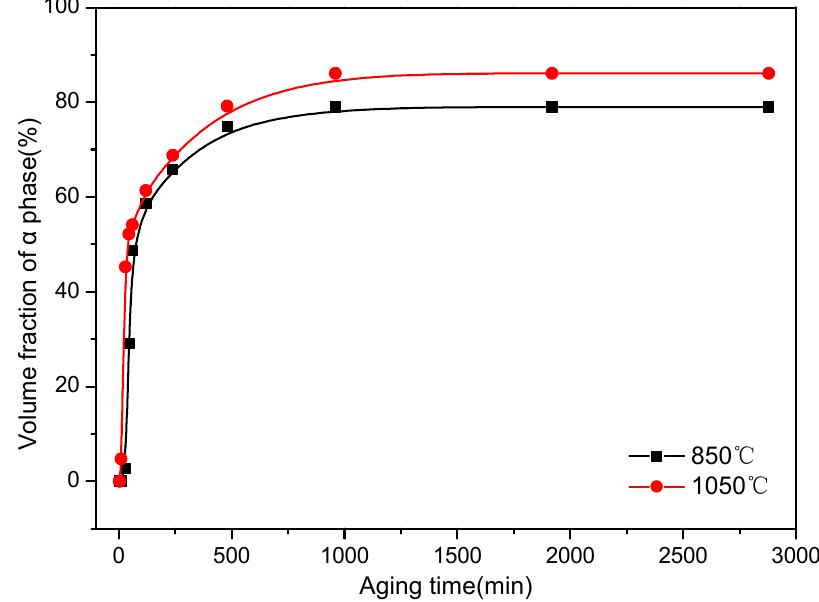
Figure 10. Variation in the volume fraction of α phase at 500 °C isothermal treatment with different aging times for the Ti–3.5Al–5Mo–4V alloy after solution treatment at 850 and 1050 °C. Points with different symbols represent measured values and lines represent simulated results.